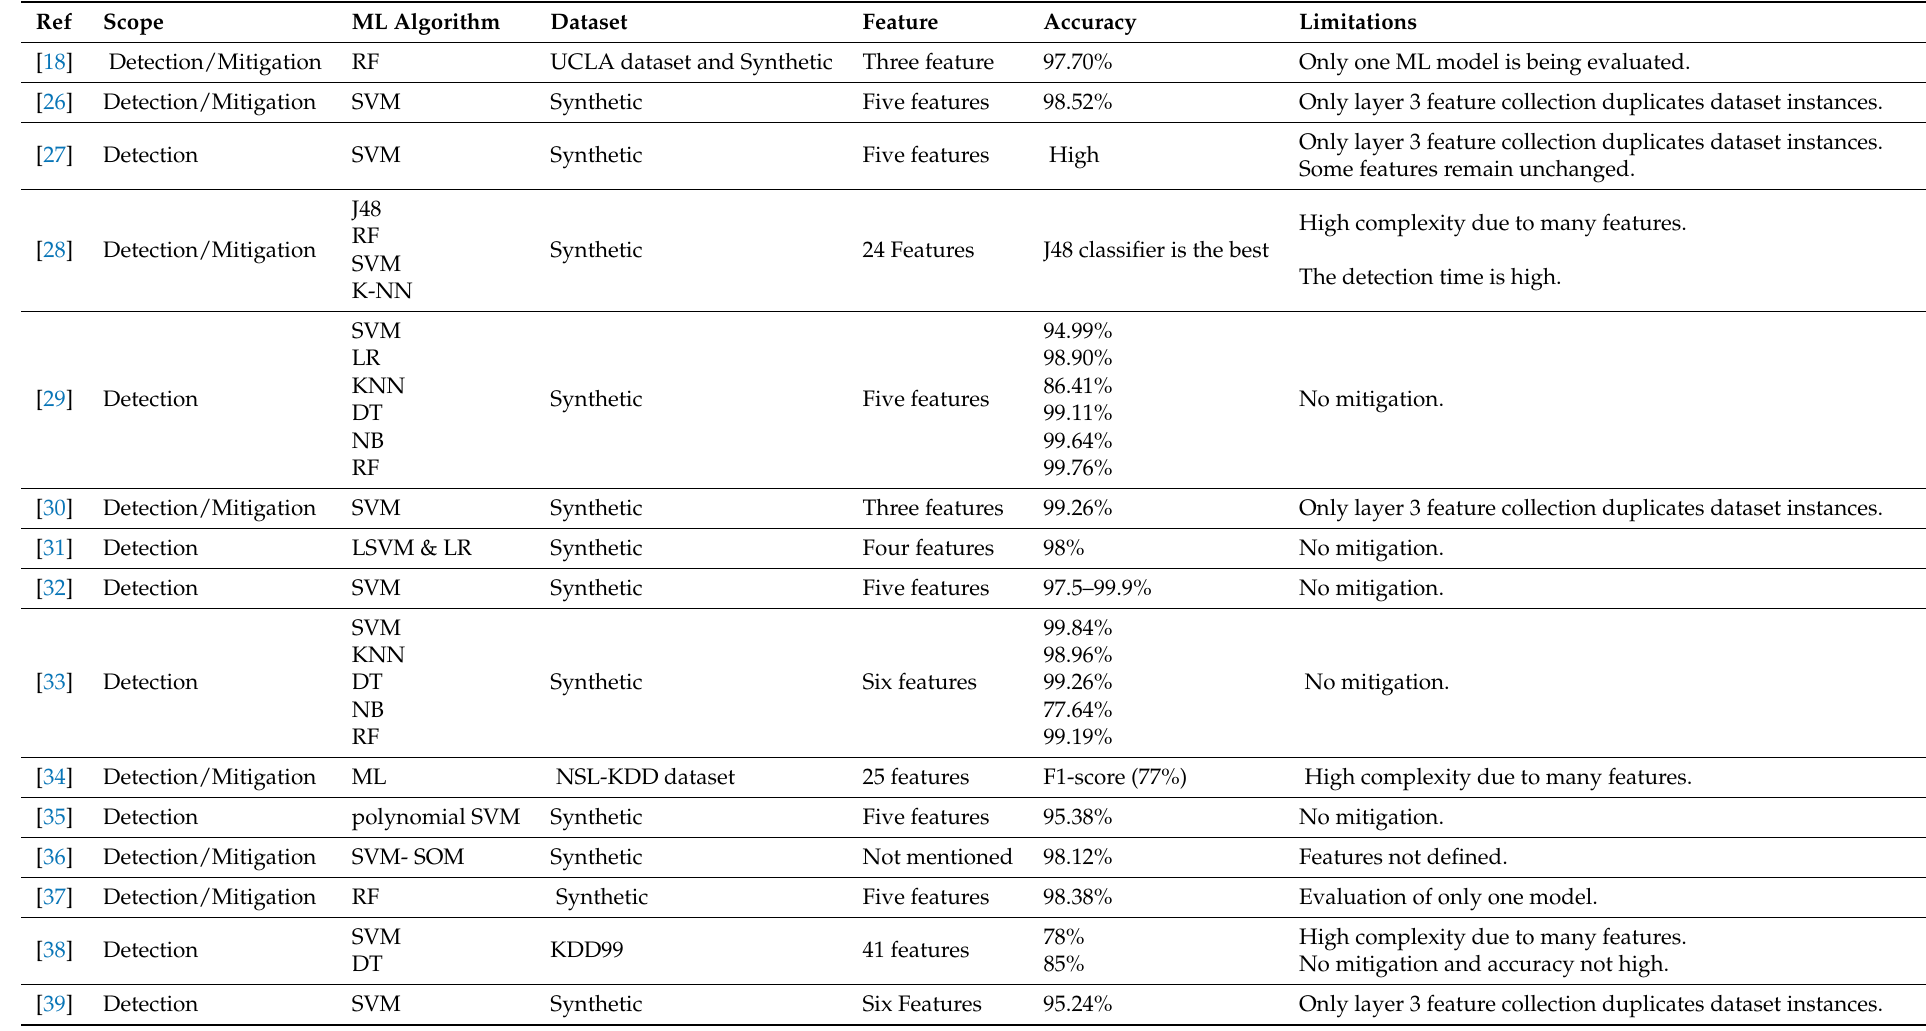
Table 1. Comparison of related